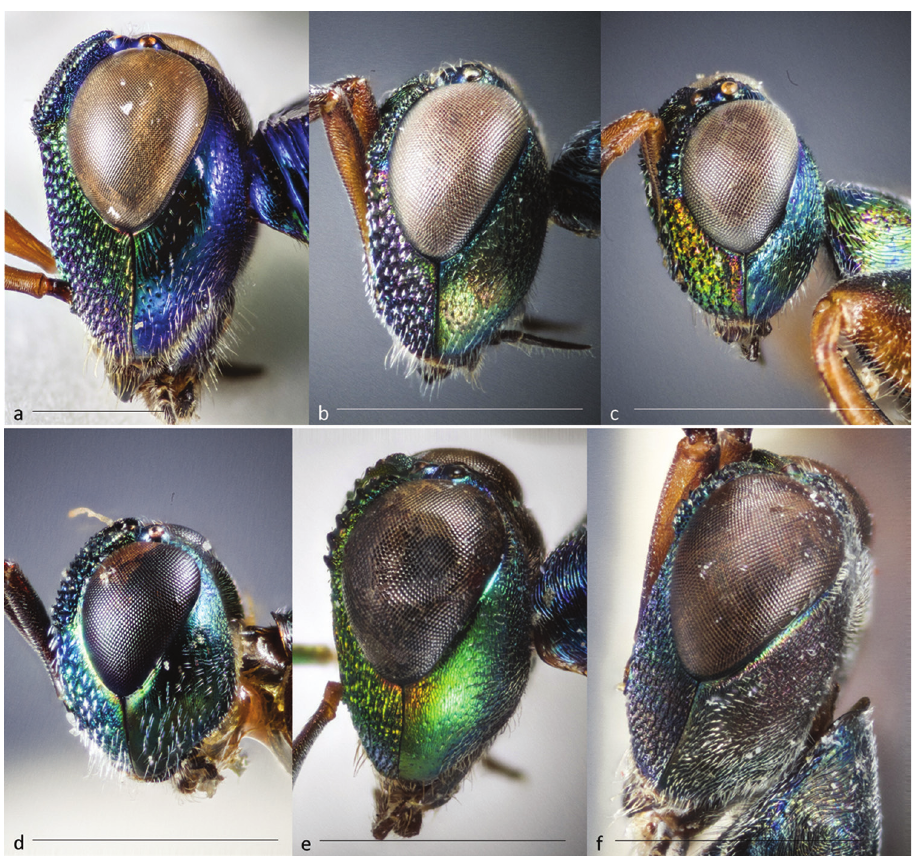
Figure 9. Head (lateral) II a O. gracilis Westwood (imaged specimen: OGr01) b O. heikewernerae sp. n. (OHe01, holotype) c O. hoggarensis Hedqvist (OHo02, paratype) d O. leibnizi sp. n. (OLe03, paratype) e O. longicollis (Cameron) (OLo01) f O. madegassa Bouček (OMad01, holotype). Scale bars: 1